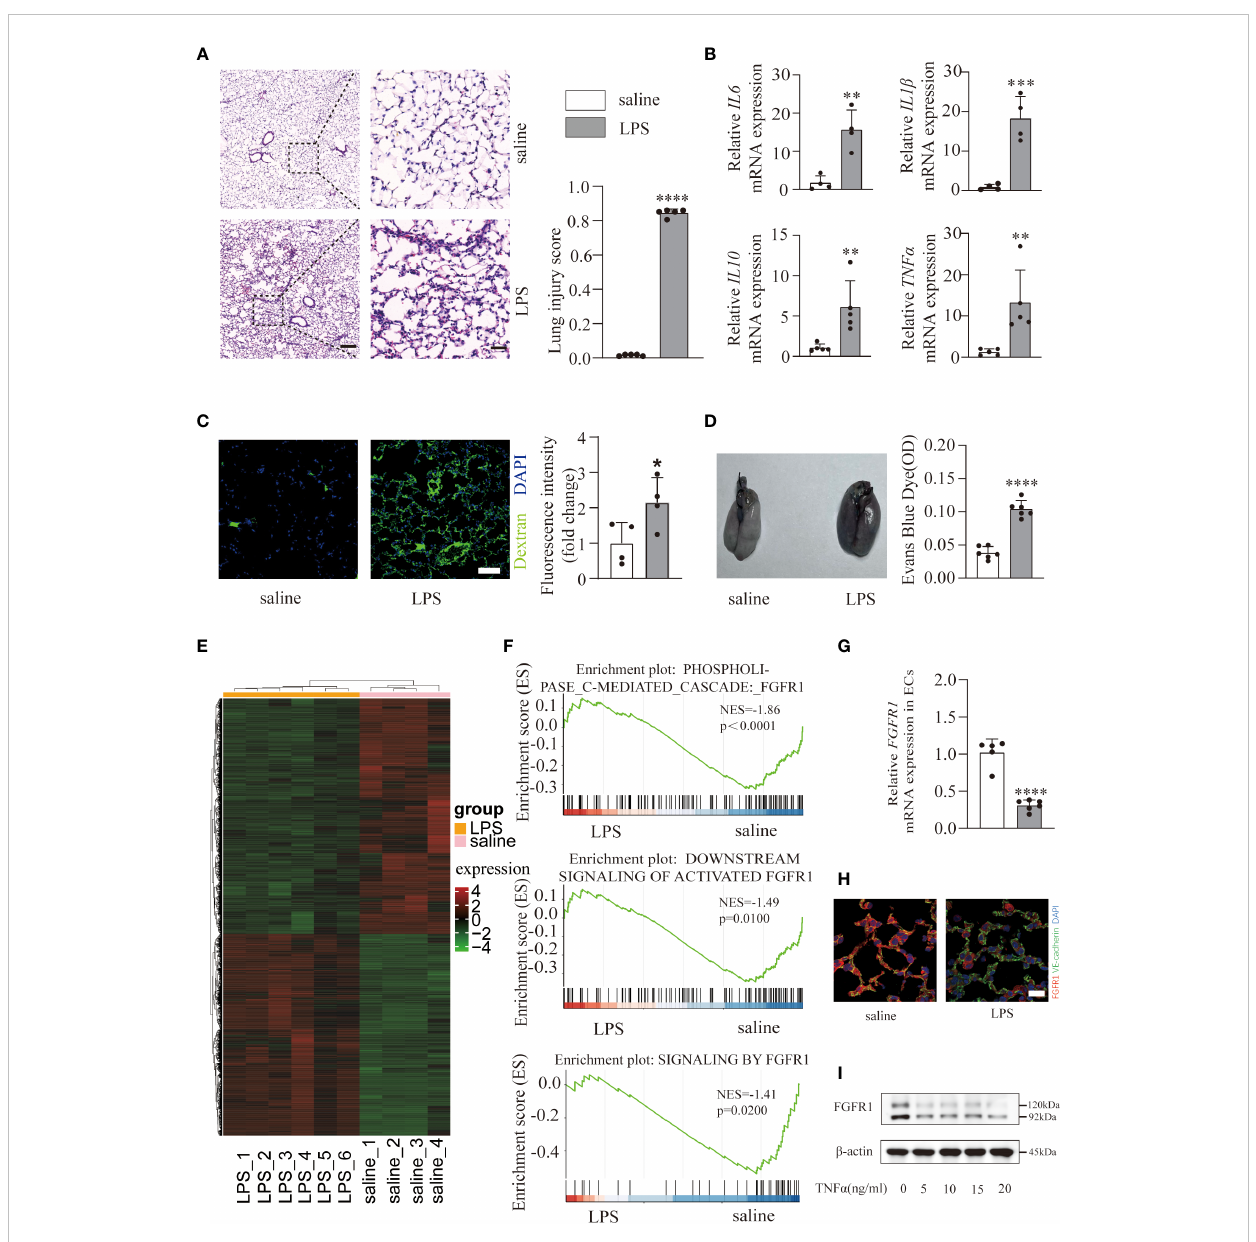
FIGURE 1 An LPS-induced ALI/ARDS mouse model was constructed and endothelial FGFR1 was decreased in the LPS group. Mice were treated with saline and LPS (10 mg/kg) intratracheally for 24 h. Representative lung sections were stained with hematoxylin and eosin and lung injury scores were quanti fi ed (A) , n=5 per group. Scale bars: 200 µm (left) and 40 µm (right). Total RNA was isolated from saline- and LPS-treated mouse lung tissues. Relative mRNA levels of in fl ammatory cytokines ( IL6 , IL1 b , IL10 , TNF a ) were signi fi cantly increased in mice treated with LPS compared with saline-treated mice, as determined by RT-PCR analysis (B) . n=4 or 5 per group. Images of FITC-dextran were costained with DAPI and quanti fi ed by the mean fl uorescence intensity of FITC-dextran (C) . n=4 per group. Scale bars: 50 µm. Whole lung tissues were stained with EBD-stained lungs (left) and EB content in the lungs (right) was quanti fi ed (D) . n=6 per group. A gene expression heatmap is shown, and hierarchical clustering was based on 2713 upregulated genes and 3167 downregulated genes between lung ECs intratracheally treated with saline and LPS (E) . n=4 or 6 per group. Gene set enrichment analysis of differentially expressed genes in the saline and LPS groups suggested decreased endothelial FGFR1 in the LPS group (F) . The relative mRNA expression of pulmonary endothelial FGFR1 in LPS-treated mice was examined (G) . n=5 or 6 per group. FGFR1 was costained with VE-cadherin in the lung sections. Red indicates FGFR1, green indicates VE-cadherin (H) . n=4 per group. Scale bars: 20 µm. HUVECs were treated with 0, 5, 10, 15 and 20 ng/ml of TNF a for 12 hours. Cell lysates were analyzed by western blotting with FGFR1 and b -actin antibodies (I) . Each bar represents the mean ± SD; *p < 0.05, **p < 0.01, ***p < 0.001 and ****p <